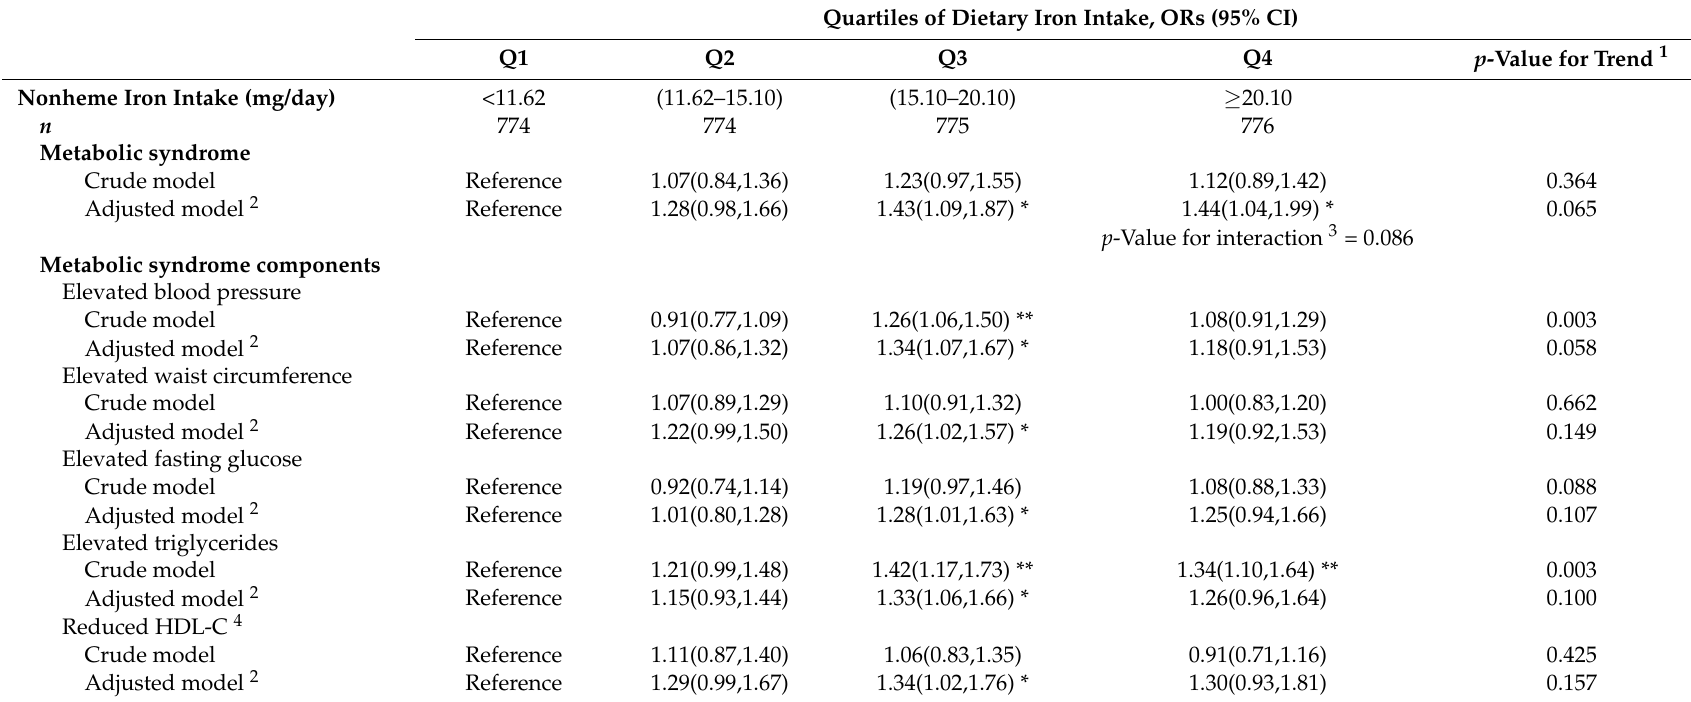
Table 4. ORs (95% CI) for metabolic syndrome and its components according to the quartiles of nonheme iron intake (mg/day) among all participants in the SDHS